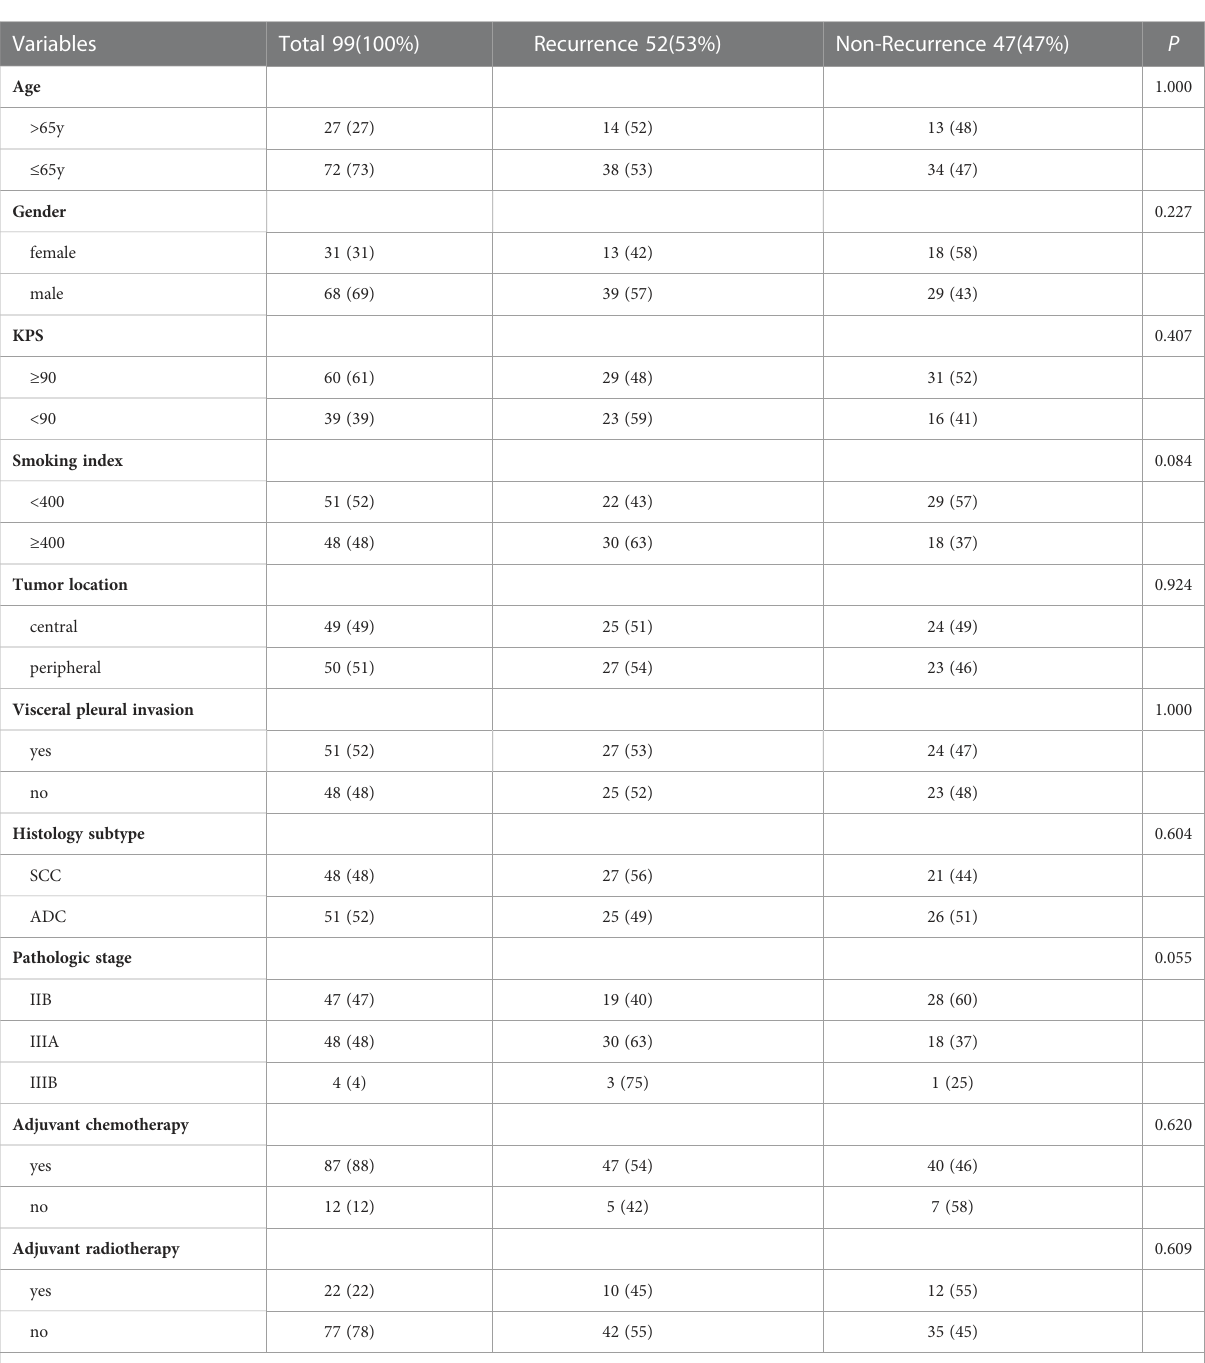
TABLE 1 Patient